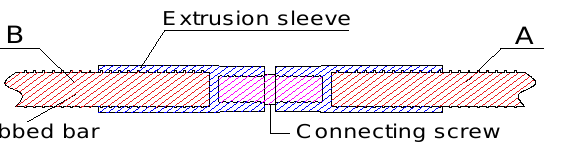
Figure 1. Sectional view of reinforcement mechanical joint specimen. “A” is the tension end and “B” is the fixed end.